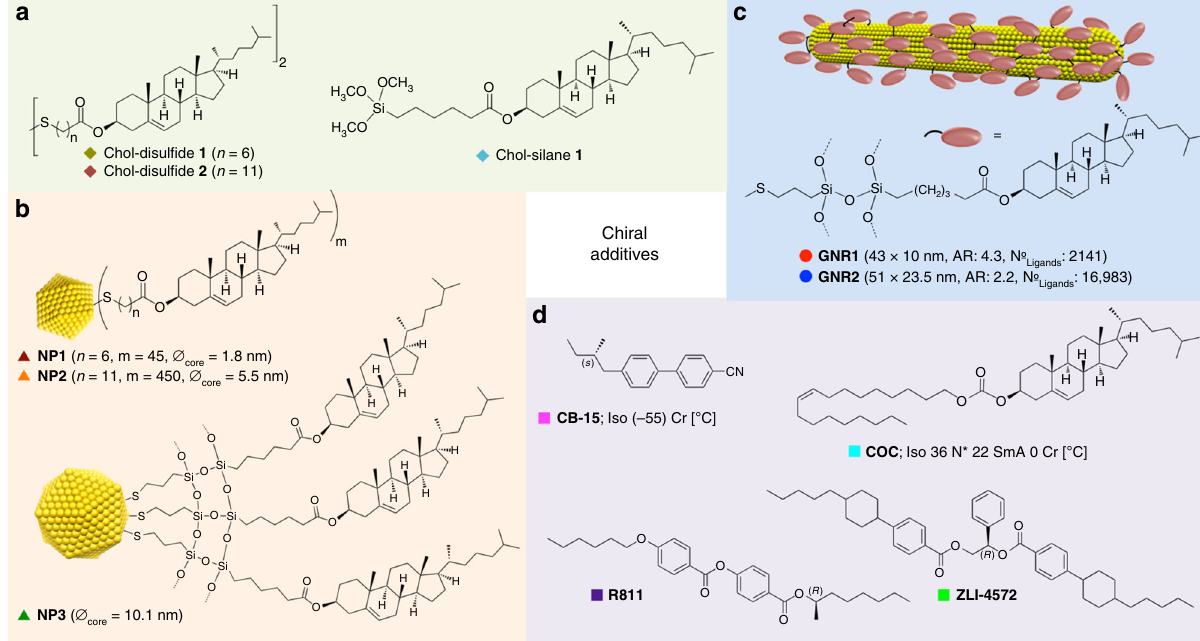
Fig. 4 Catalogue of chiral additives. Chemical structures and additional information on the chiral additives in 5CB compared in this study (see Table 1): ( a ) chiral ligands, ( b ) chiral ligand-capped Au NPs 21 , ( c ) chiral ligand-functionalized GNRs, and ( d ) commercially available chiral additives with a range of β W and β mol values